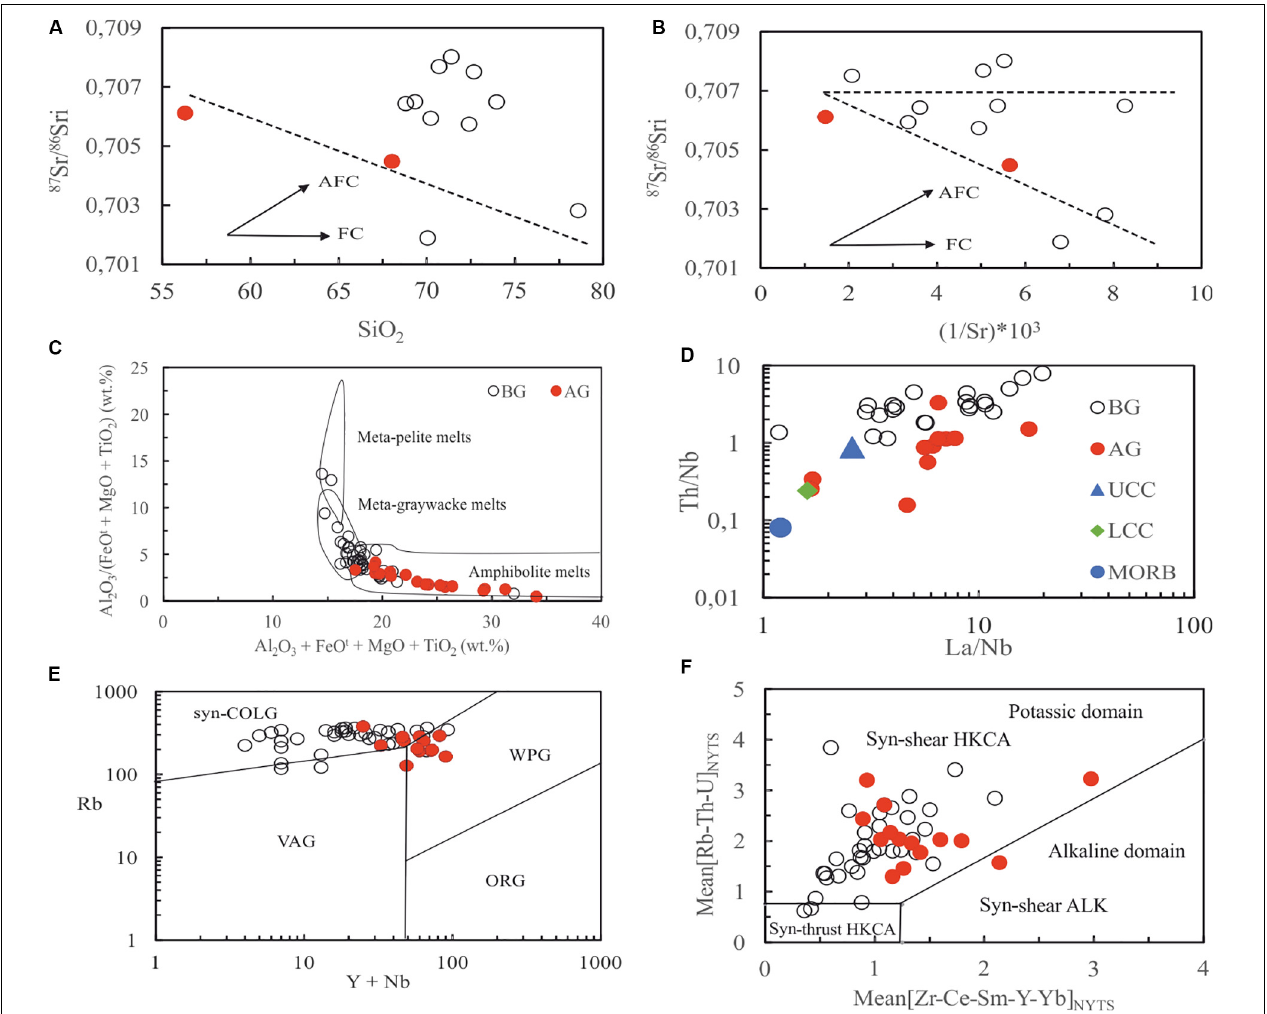
FIGURE 9 | (A) Plots of ( 87 Sr/ 86 Sr) 620 Ma vs. SiO 2 and (B) ( 87 Sr/ 86 Sr) 650 Ma vs. 1/Sr ∗ 10 3 show that Batié granites are not only controlled by fractional crystallization (FC). The oblique line indicates the metasomatism trend. (C) Compositional comparison between the Batié granites with those partial melts from metapelites, metagreywackes, and amphibolites (after Patiño Douce, 1999). (D) Diagram Th/Nb vs. La/Nb showing mainly the crust contribution of Batié granite magmas [upper continental crust (UCC) and lower continental crust (LCC) values are from Rudnick and Gao (2003), and Mid-Ocean ridge basalt (MORB) values are from